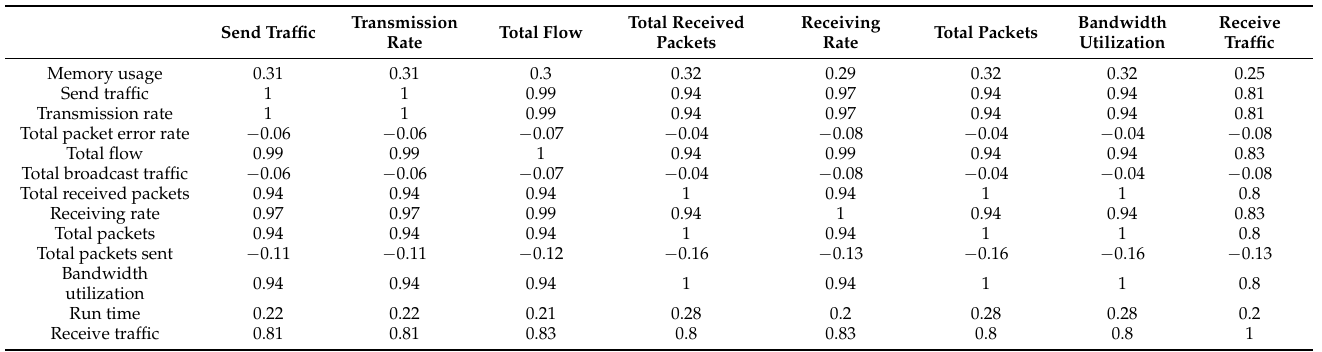
Table 2. Characteristic correlation analysis.